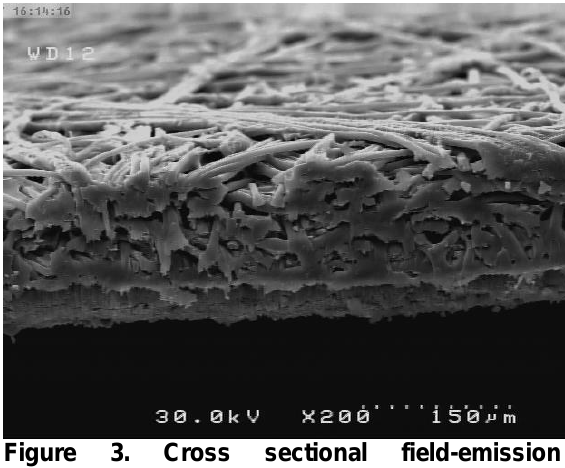
Figure 3. Cross sectional field-emission Figure 4. Effect of graphene oxide content on